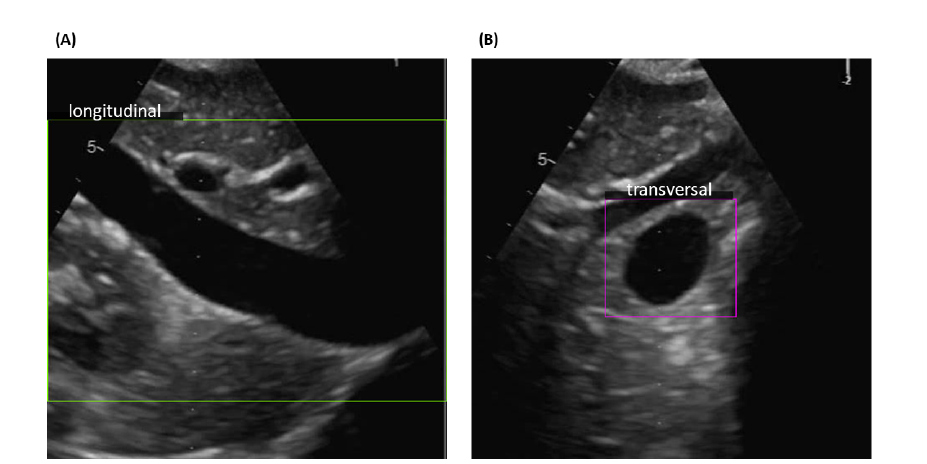
Figure 2. Examples of YOLO detection outputs. ( A ) Longitudinal and ( B ) Transversal view of IVC and their respective detected areas.